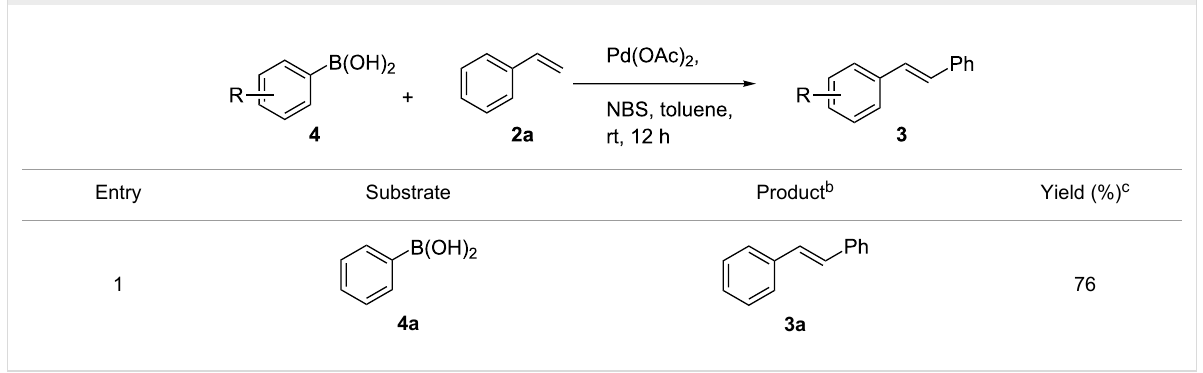
Table 5: Substrate scope in Heck arylation reaction of phenylboronic acids with olefins.